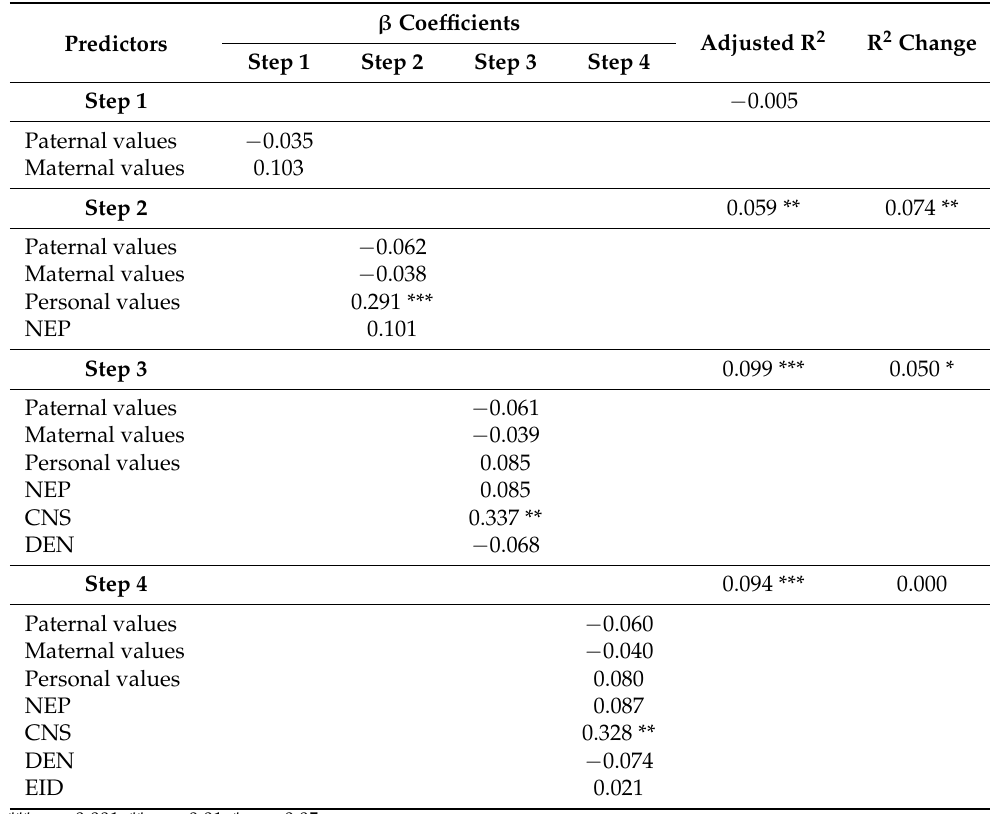
Table 5. HMRA: predictors of sustainability in everyday